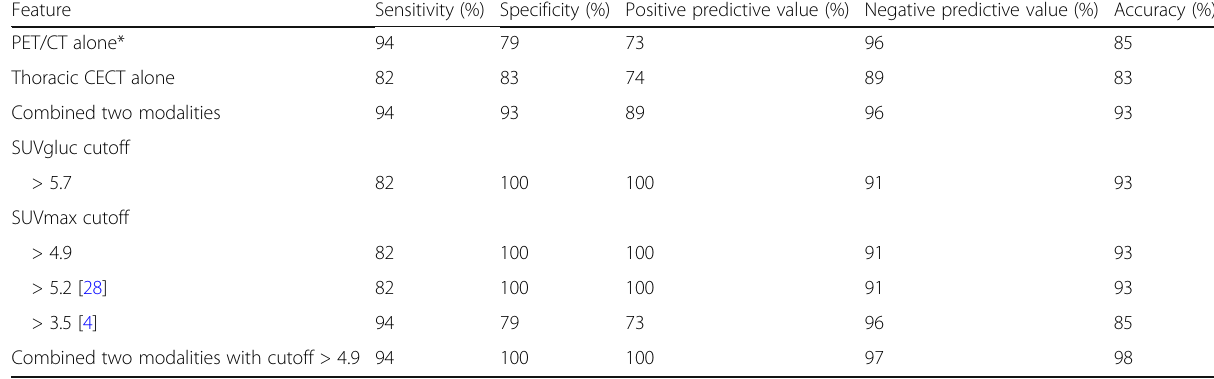
Table 2 Diagnostic performance of various parameters